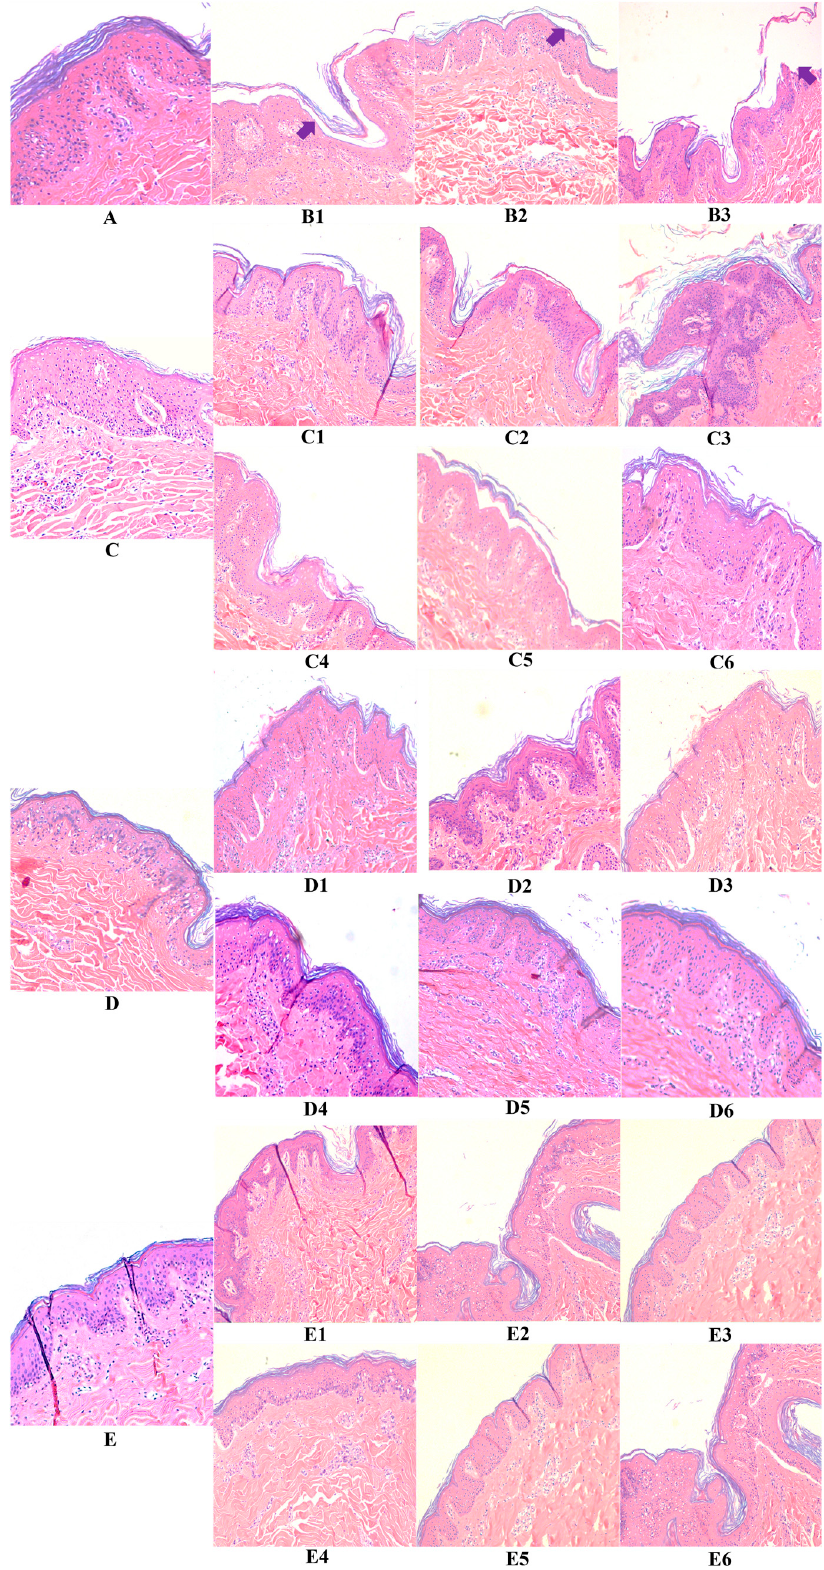
Figure 2. 10 × magnification eosin-hematoxylin stained tissues after 24 h infection with Staphylococcus aureus ATCC29213 and DSM20491 ( panels B1 , B2 ), FCS ( panel B3 ), untreated ( panel A ) and treated (pre-incubated and coincubated) tissues with HA ( panels C1 – C6 ), c40 ( panels D1 – D6 ) and HAc40 ( panels E1 – E6 ).